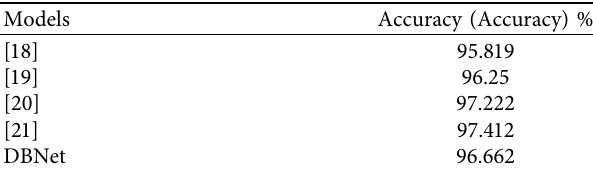
Table 12: Comparison of experiment results. Models